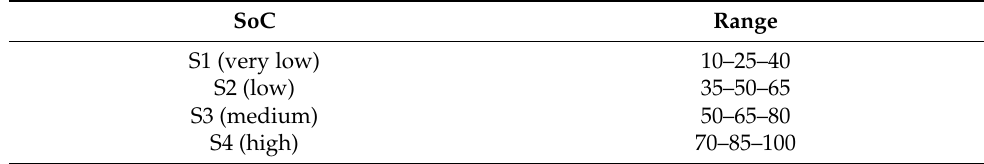
Table 2. Range of state of charge (SoC).